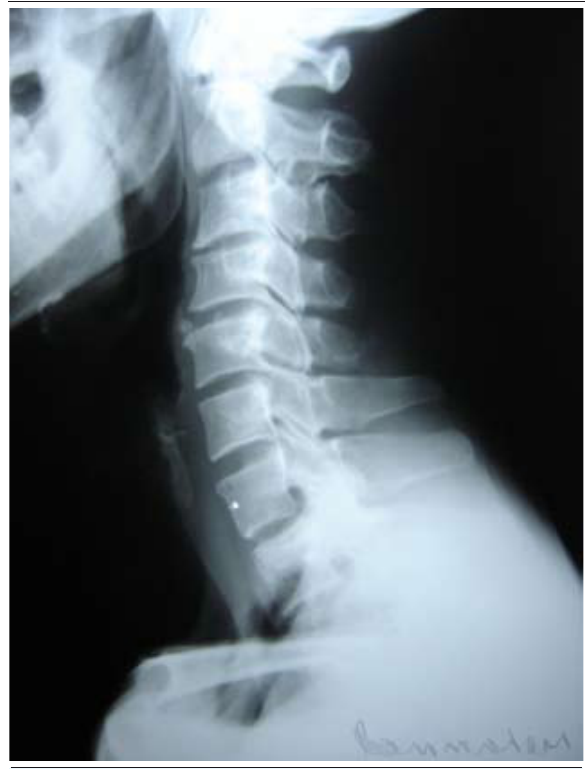
Figure-1.X-ray cervical spine showing all cervical vertebrae